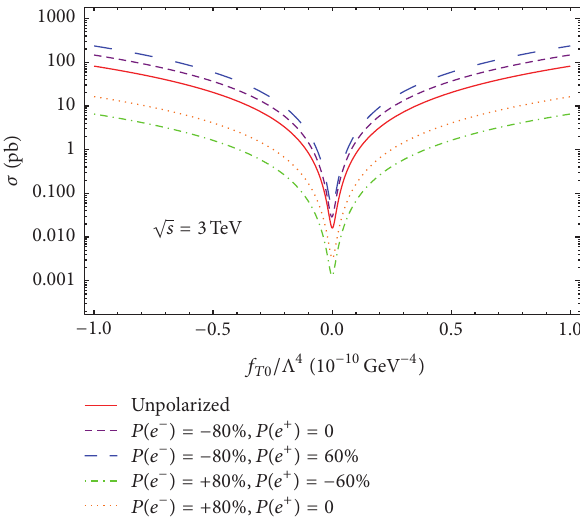
Figure 7: The total cross section for 𝑒 + 𝑒 − → ] 𝑒 𝑊 − 𝑊 + ] 𝑒 processes as a function of 𝑓 𝑇0 /Λ 4 at the √𝑠 = 3 TeV for different polarization of the positron and electron